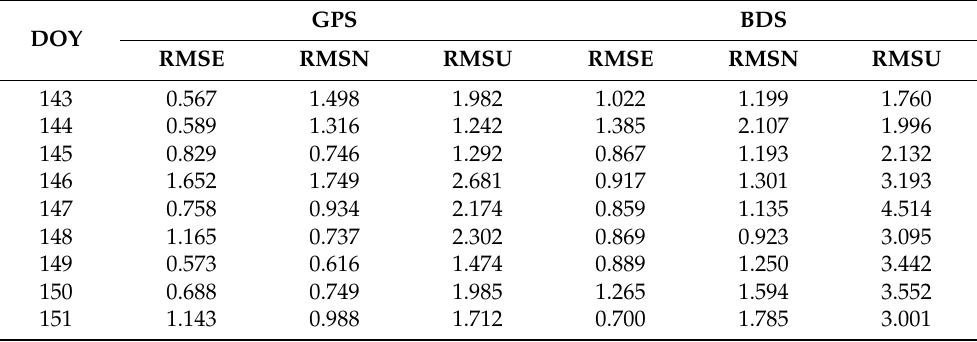
Table 2. Position residuals of single-point positioning (SPP) with GPS and BeiDou Navigation